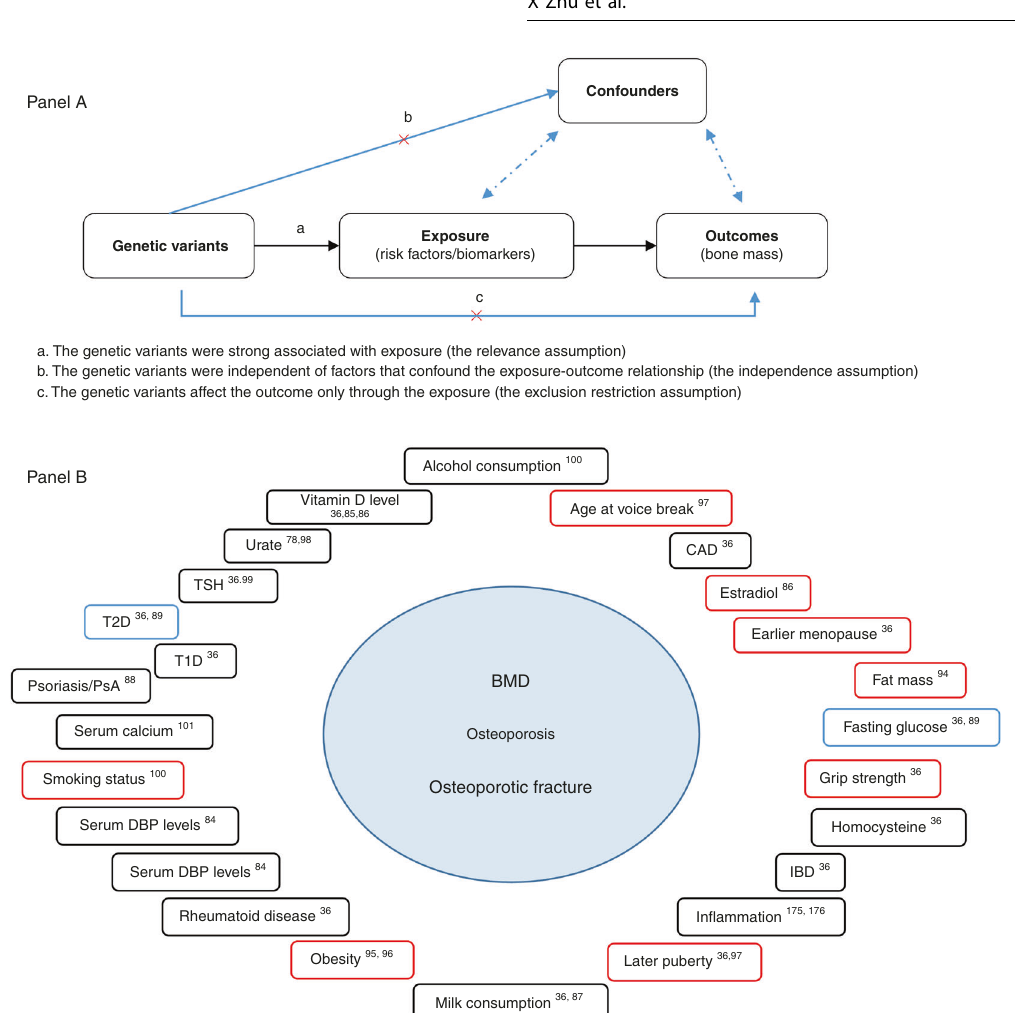
Fig. 3 Mendelian randomization in bone fi eld. Panel A : Principal of Mendelian randomization. Panel B : The causality between the clinical risk factors and osteoporosis from the current literature. Red boxes indicate the causal relationship. Black boxes indicate the noncausal relationship. Blue boxes indicate controversial results. BMD bone mineral density, CAD coronary artery disease, IBD in fl ammatory bowel disease, DBP vitamin D binding protein, PsA psoriatic arthritis, T1D type 1 diabetes, T2D type 2 diabetes, TSH thyroid stimulating